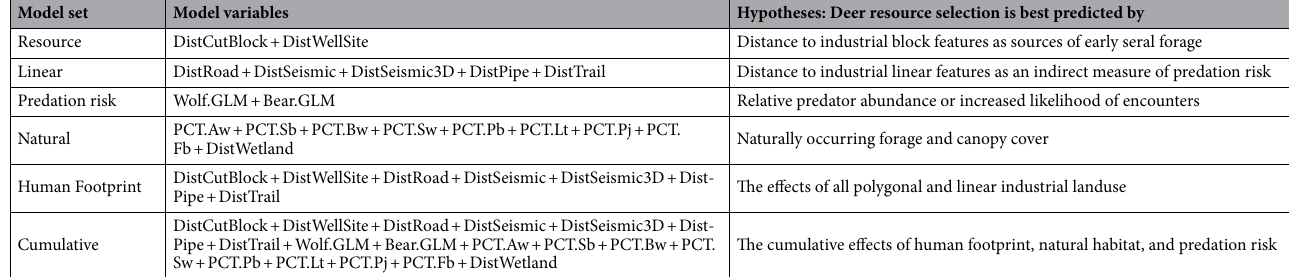
Table 2. White-tailed deer population scale Resource Selection Function (RSF) hypotheses and corresponding model sets and variables in northeastern Alberta. Each model set was tested across four seasons: winter, parturition, rut and summer to detect seasonal variation in selection. All distance variables were log- transformed. Variable descriptions can be referenced in Table 1.